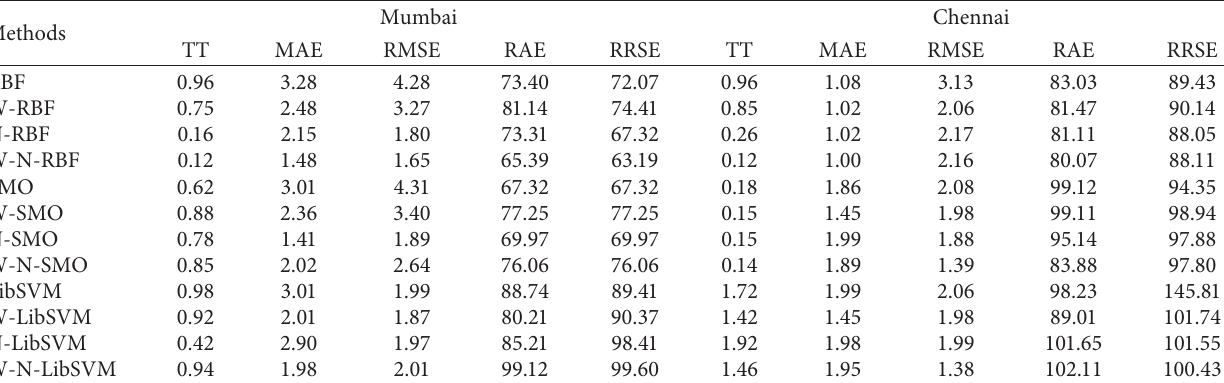
Table 8: Comparison of errors and time taken for wind speed, Mumbai and Chennai.